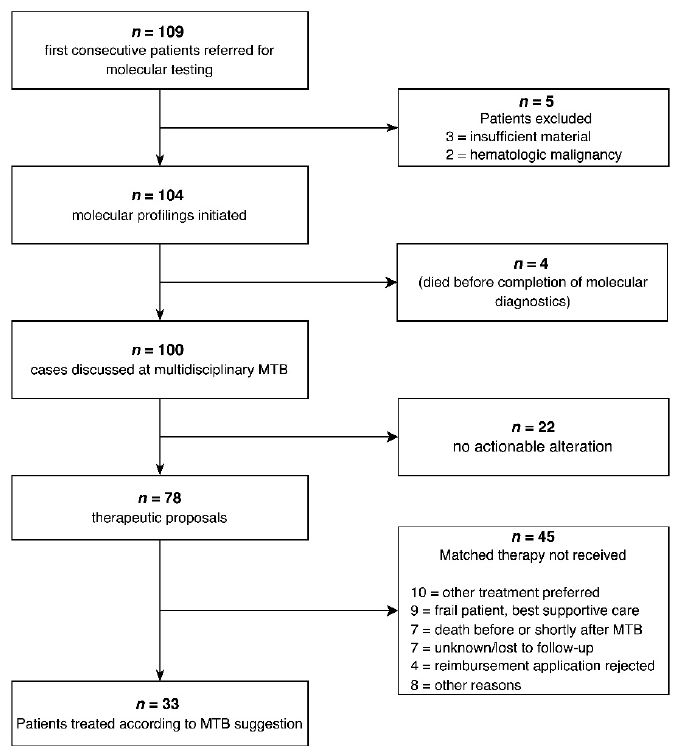
Figure 1. CONSORT diagram—outline of the implementation of precision oncology in clinical practice. Initially, 109 patients were referred for molecular testing, aiming at individual targeted therapies. Thirty ‐ three patients (30%) received matched therapies.